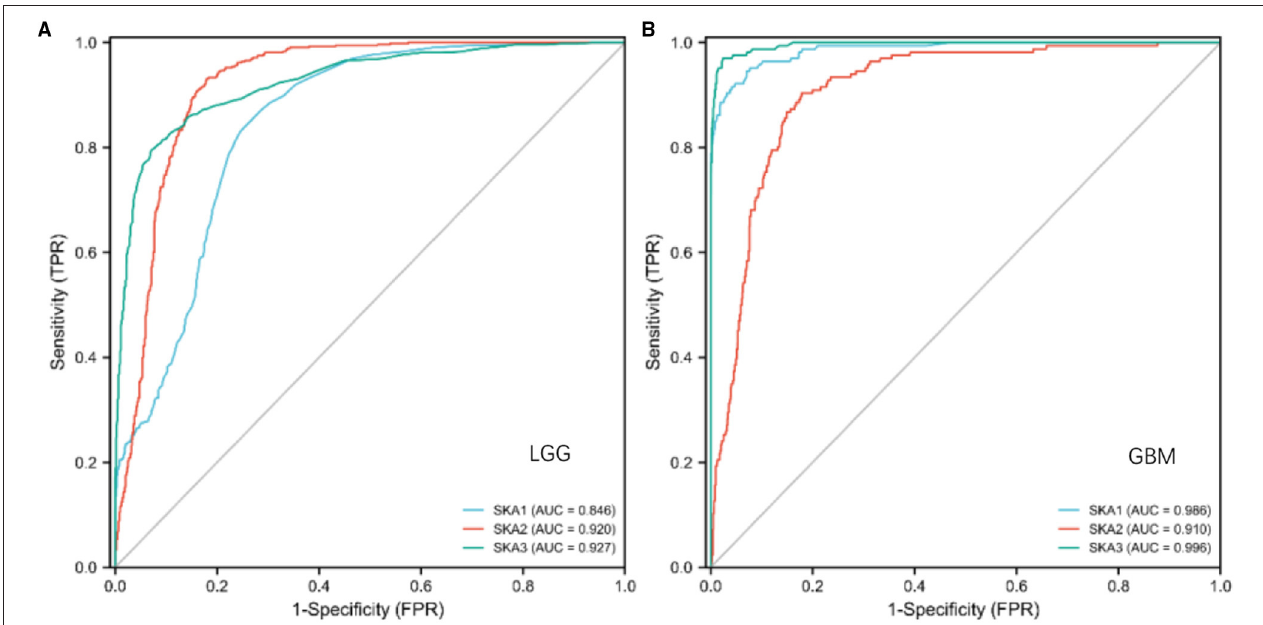
FIGURE 4 | The diagnostic values of SKA complex in patients with gliomas. (A) LGG; (B) GBM.